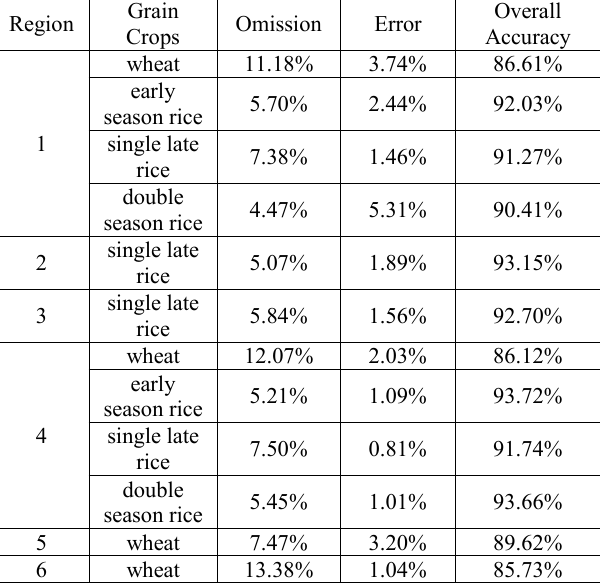
Table 5 Overall accuracy of grains monitor of figure 9 on